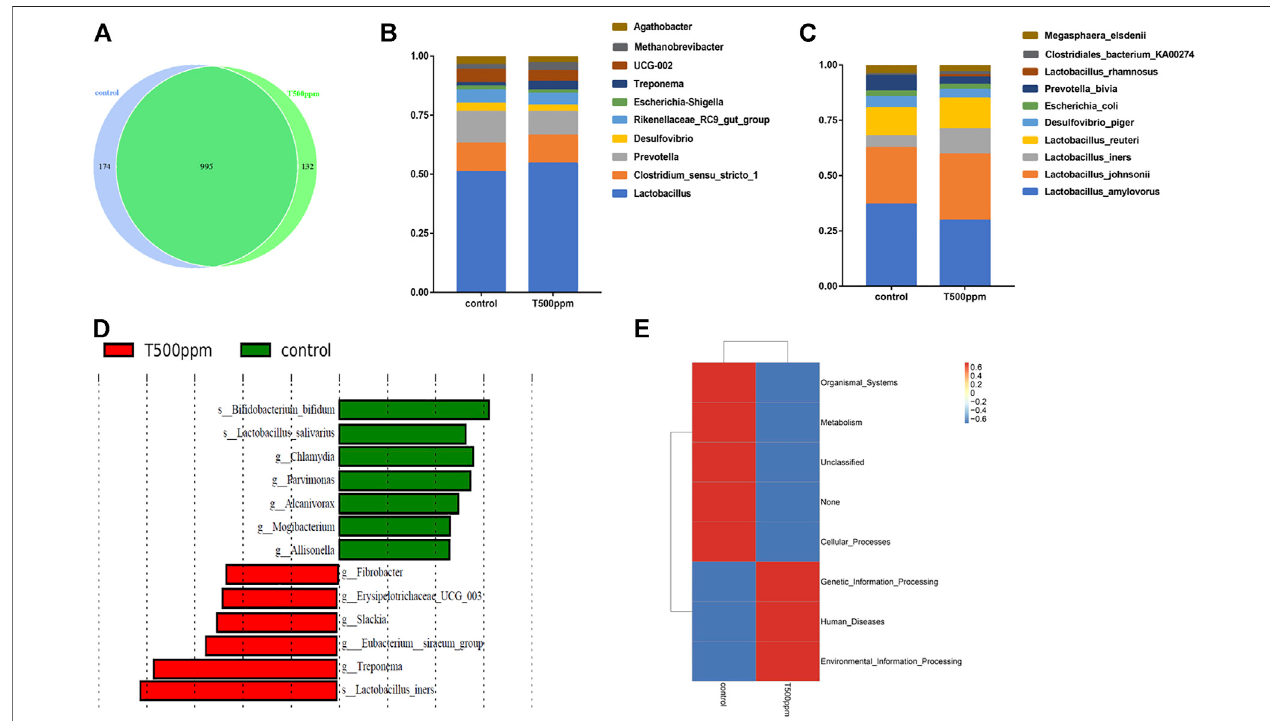
FIGURE 4 | (A) Venn diagram of the OTU analysis of intestinal microorganisms. (B) TOP 10 of the genus relative abundance histogram at the genus level. (C) TOP 10 of the species relative abundance histogram at the species level. (D) LDA effect size analysis. (E) PICRUSt functional annotation clustering heat map.